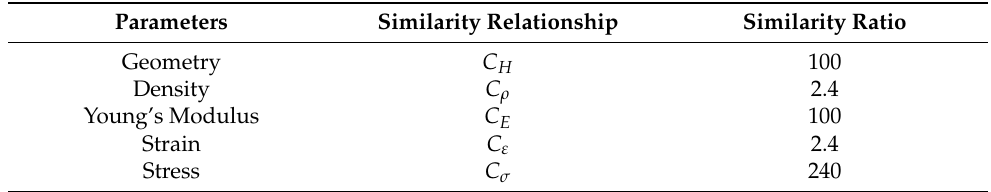
Table 1. Physical Parameters and Similarity Ratio.